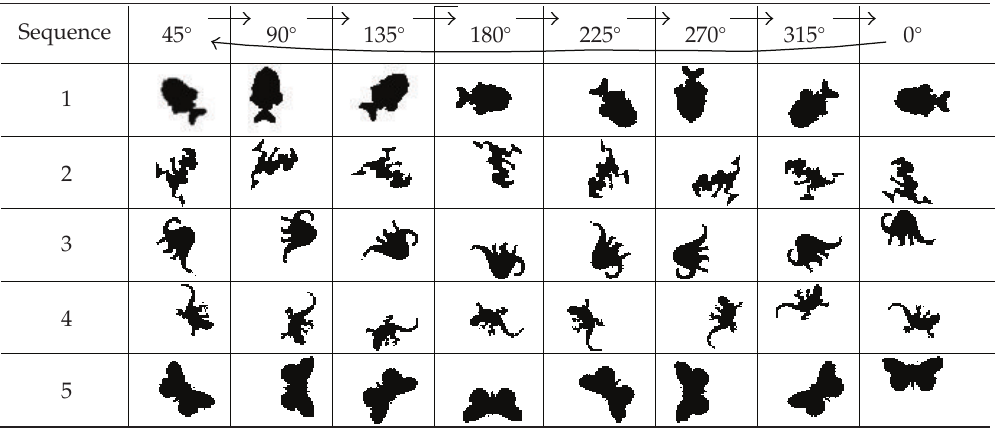
Table 7: Five binary sequences composed of 8 time steps.